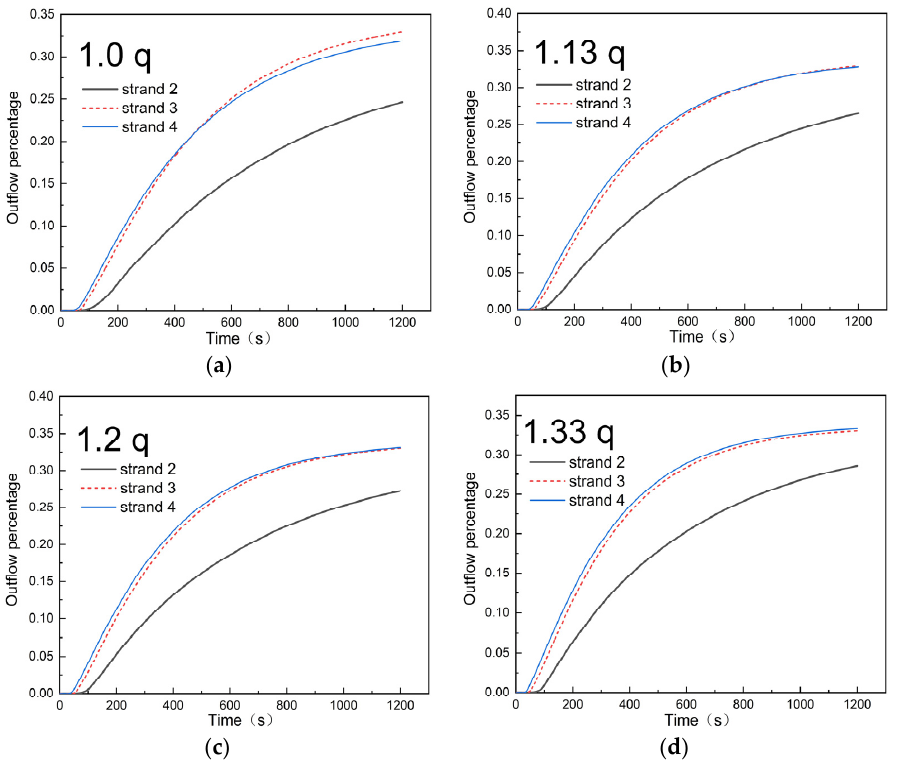
Figure 14. Outflow percentage curve of the double-weir tundish with uniform increasing casting flow rate under strand 1 blockage condition: ( a ) 1.0 q, ( b ) 1.13 q, ( c ) 1.20 q, ( d ) 1.33 q.